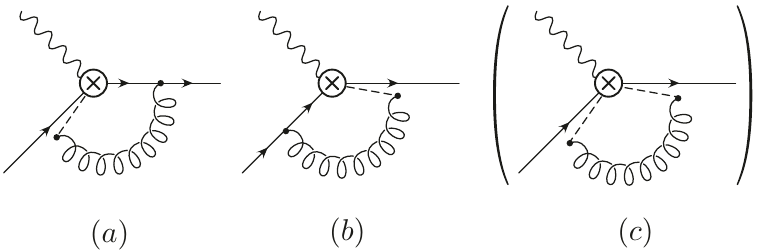
Figure 4 . Renormalization of O 2 . Diagram (c) is the overlap subtraction. In (a), the gluon is in the n sector; in (b), it is in the (cid:22) n sector. In (c), the dashed lines represent Wilson lines Y n; (cid:22) n , depending on their direction. The divergences in (a) and (b) cannot be absorbed by a counterterm in SCET. gluons are included in both loop integrals, and therefore double-counted. Subtracting the double-counting gives the formula